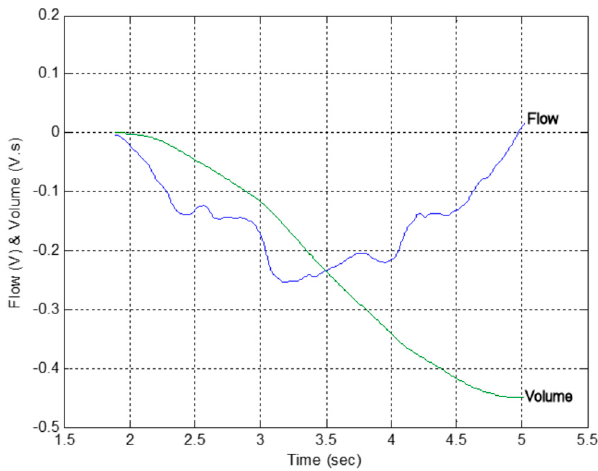
Figure 11. Filtered flow rate and integrated volume in measurement units after digital processing.